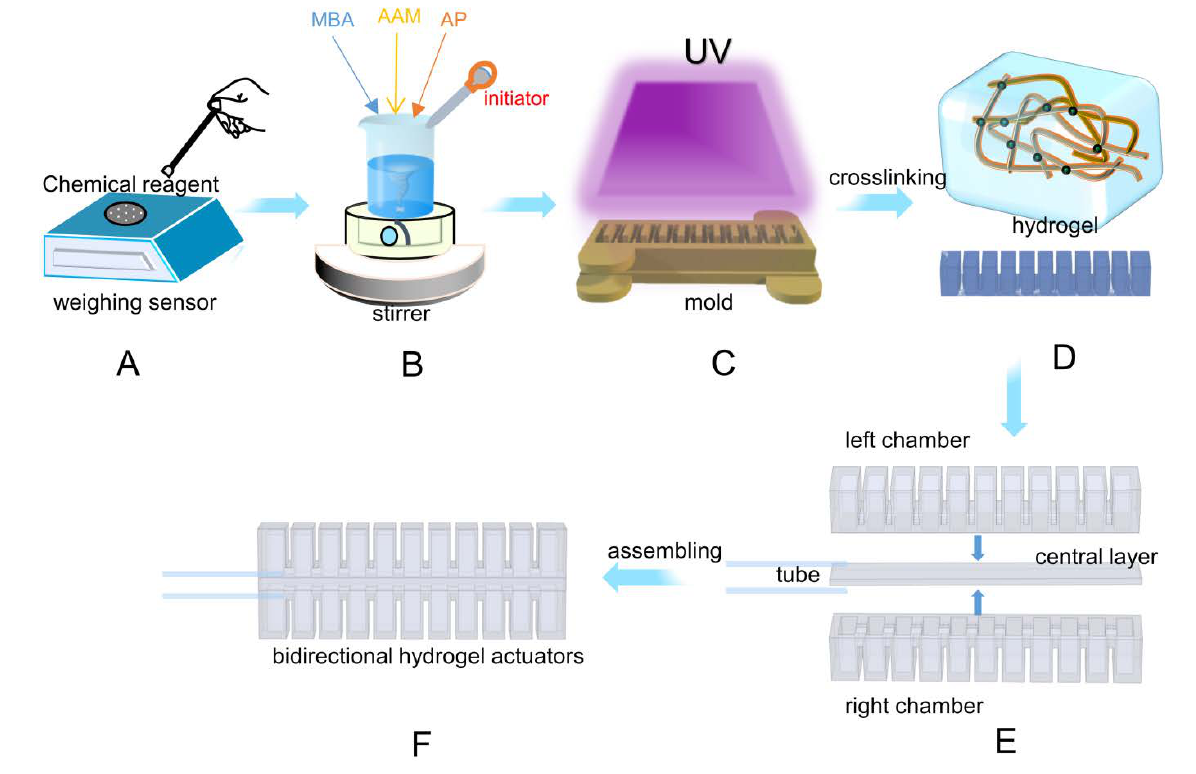
Figure 1. The fabrication process of the bi-directional bending actuator. ( A , B ) The process of preparing precursor liquid. ( C , D ) We pour the precursor into the prepared mold at night for cross-linking curing under UV light. ( E , F ) We get two symmetric chambers and an intermediate layer after mold release. We glue them with binder and assemble them into a bidirectional bending actuator. The actuator is composed of two chambers, a central layer, and elastomer